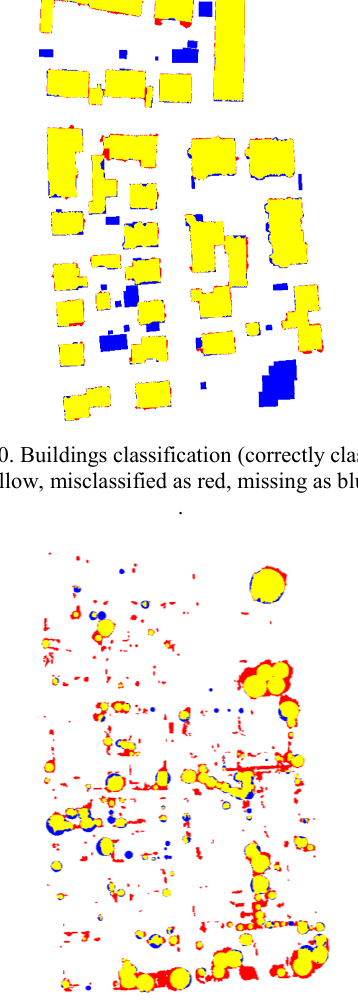
Figure 11. Trees classification (correctly classified as yellow, misclassified as red, missing as blue)